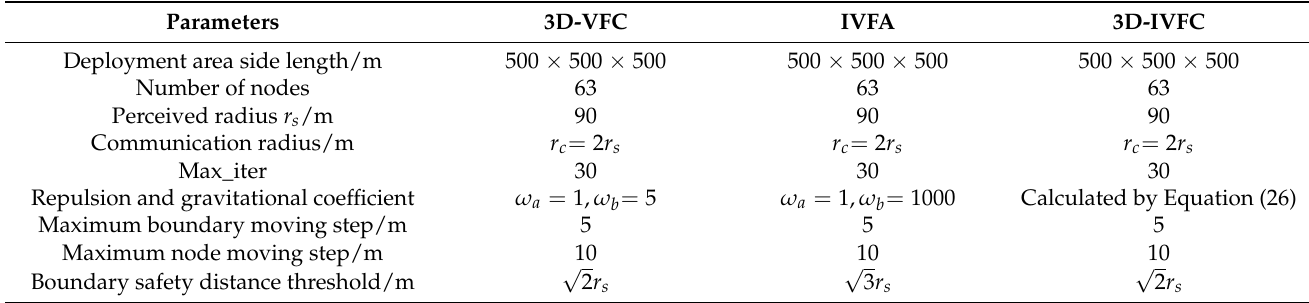
Table 1. Parameter Table 1. Parameter setting.